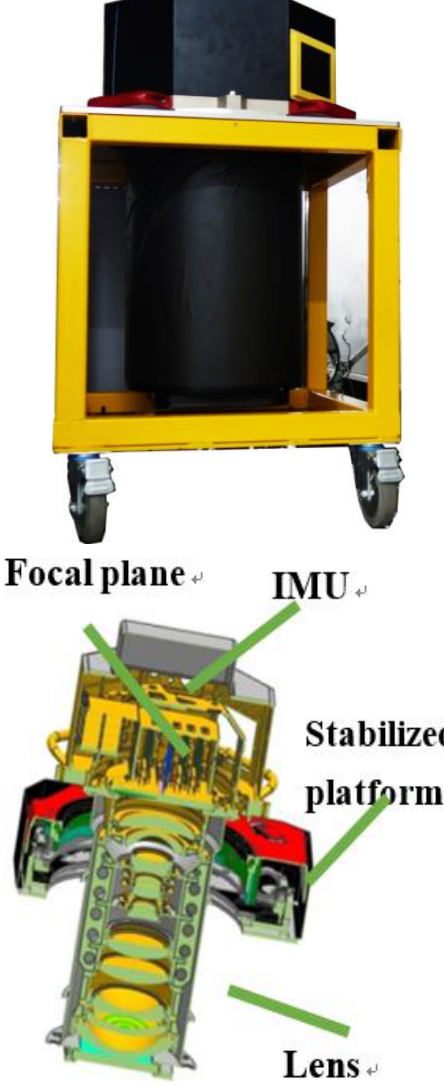
Figure 2. AMS-3000 camera structure With a scan line width of 32,000 pixels and a base height ratio of 0.89, AMS-3000 supports panchromatic image and RGB color image photographing, which is significantly larger than the mainstream aerial photography cameras. At the flight height of 2400m, the camera can cover 3000m in a single flight band and acquire 0.1m resolution remote sensing image of 180 square kilometers in 10 minutes, which has very high